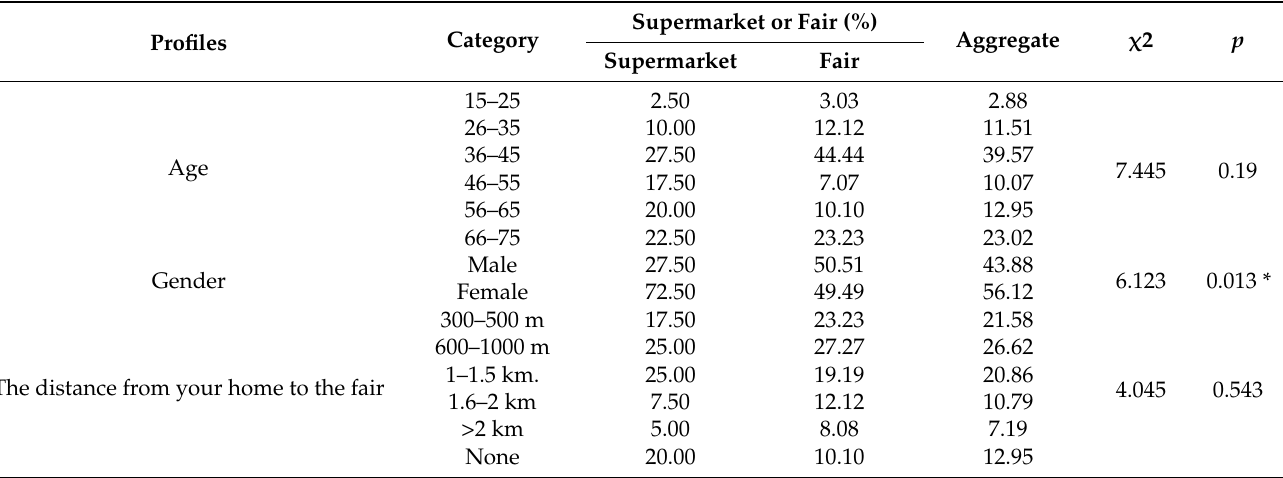
Table 2. Analysis of gender and age in choosing supermarket and